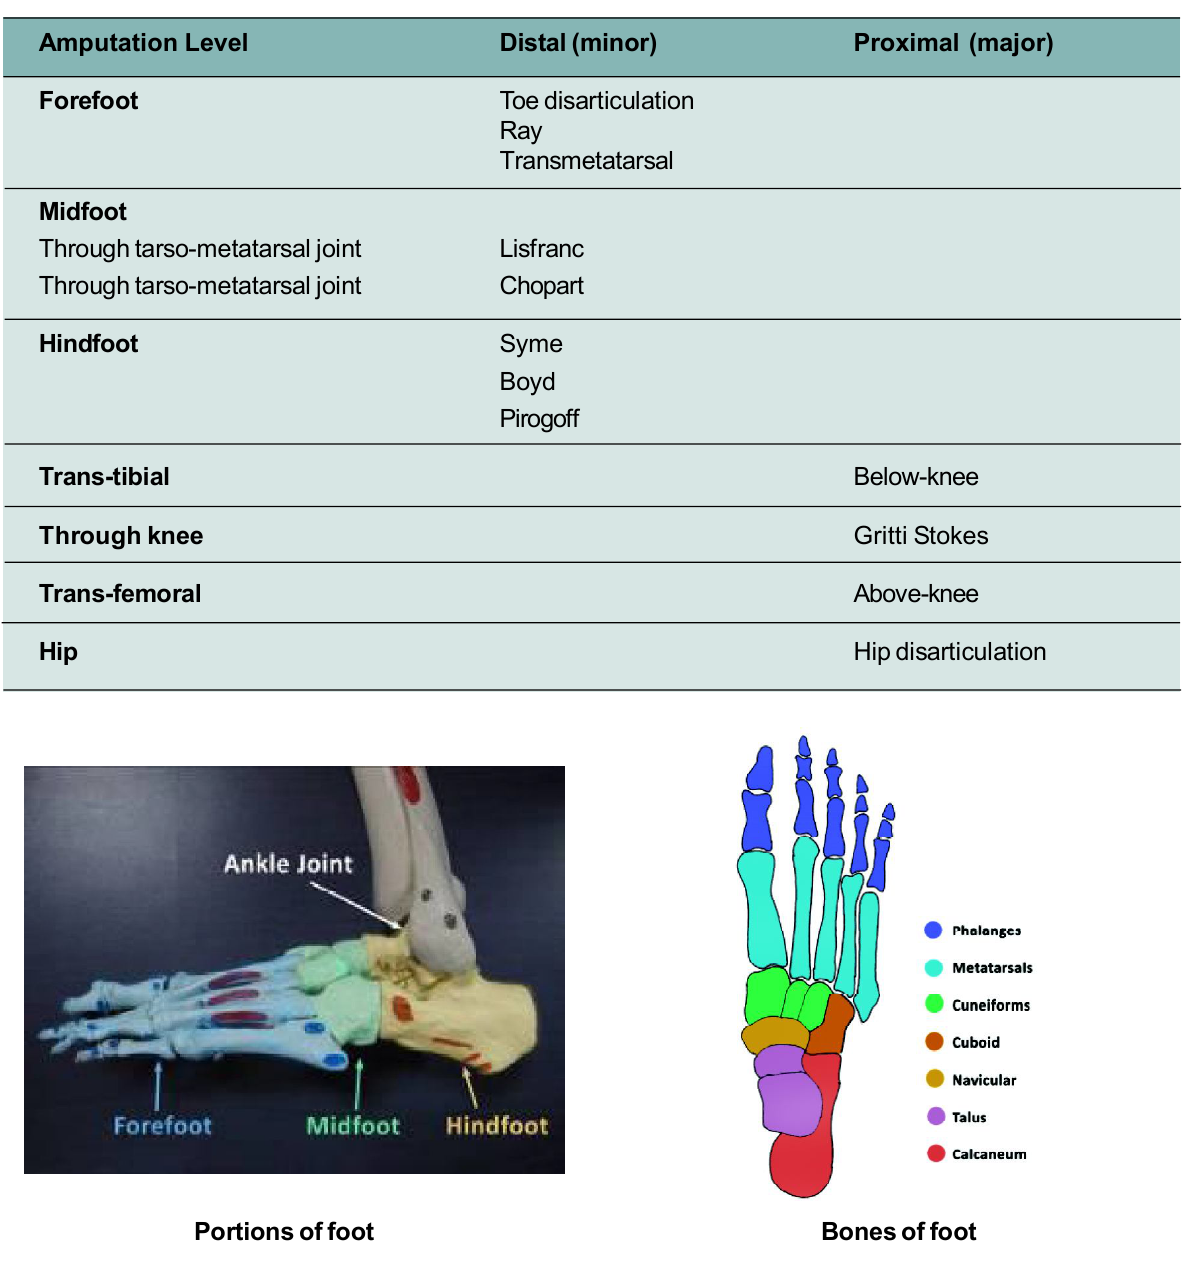
Table 7. Classification of Amputations (Nather and Wong 2013)